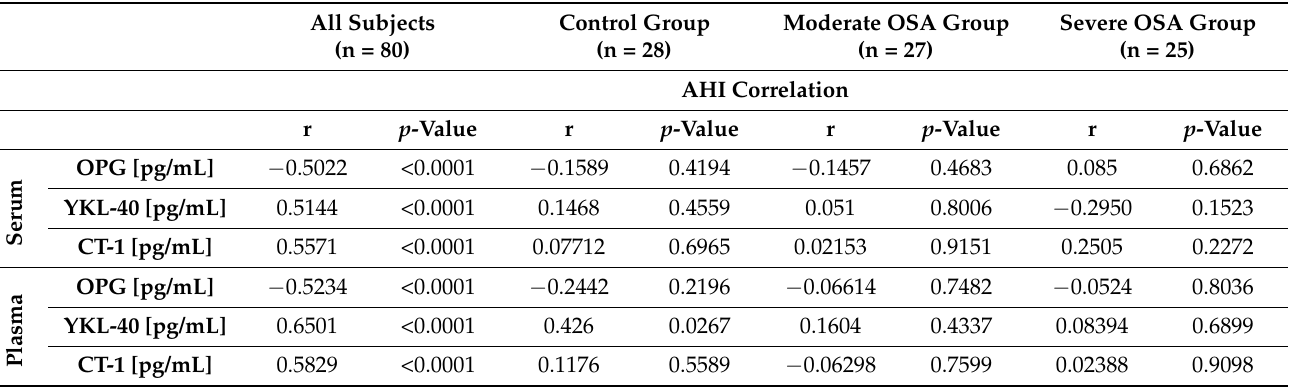
Table 3. Spearman’s correlation coefficients between AHI and the concentrations of OPG, YKL-40, and CT-1 in the serum and